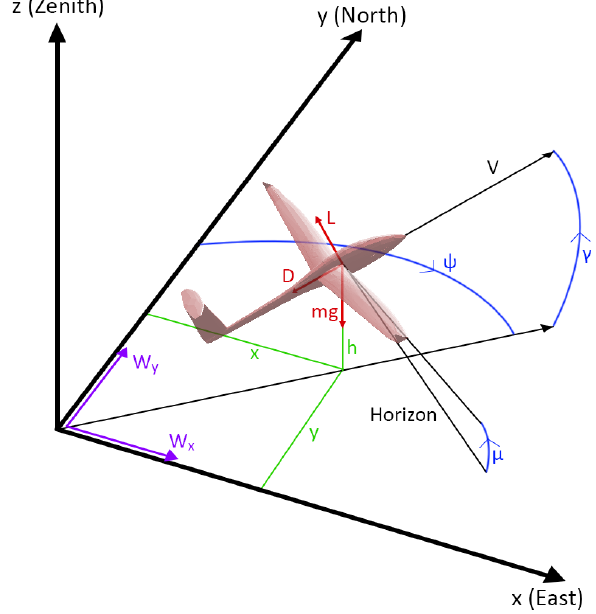
Figure 1. Free body diagram of the flight agent